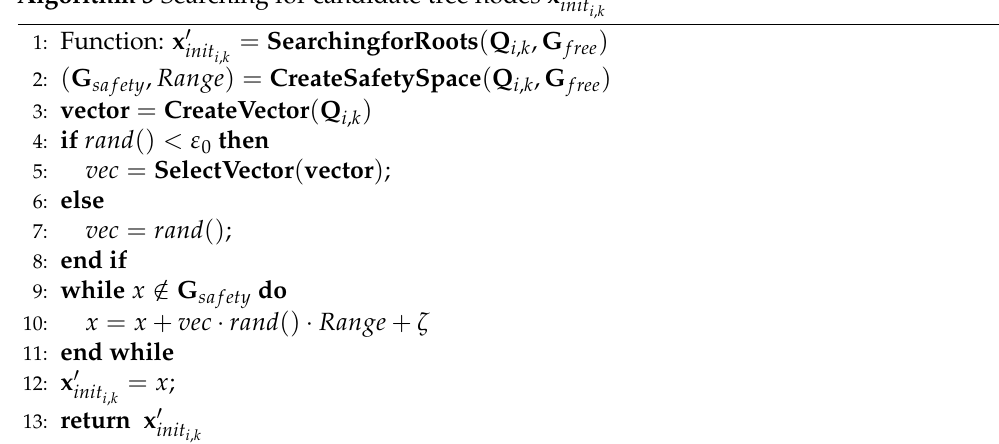
Algorithm 3 Searching for candidate tree nodes x (cid:48)